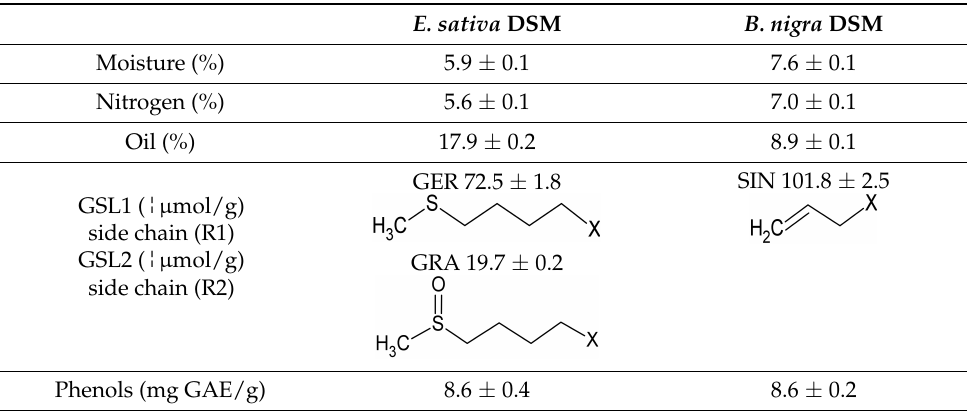
Table 1. Chemical characterization of E. sativa and B. nigra DSMs. Nitrogen and oil content are expressed as % w/w (based on dry weight). GSL content is expressed in µ mol/g and total phenolic content in mg gallic acid equivalent (GAE)/g of DSM. Mean values ± standard deviation ( n = 3) are shown. GSL common variable side chain (R) chemical structure is also indicated where X represents the GSL S-glucopyranosyl thiohydroximate moiety. GER, GRA, and SIN indicate the GSL glucoerucin, glucoraphanin, and sinigrin respectively.